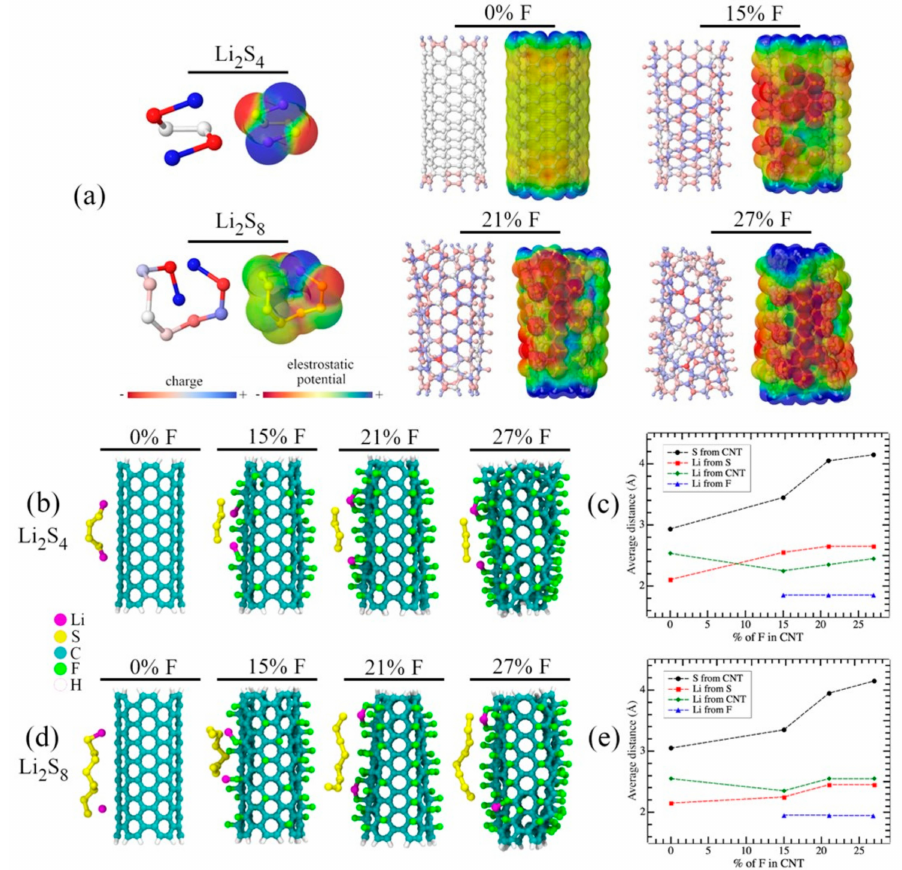
Figure 4. ( a ) Charge distribution and the electrostatic potential surface of the studied systems after geometry optimization. ( b ) Li 2 S 4 in contact with the pristine and fluorinated CNT and ( c ) the average distance between each constituent as a function of the percentage of fluorination. ( d , e ) The corresponding ones for Li 2 S 8 in contact with the pristine and fluorinated